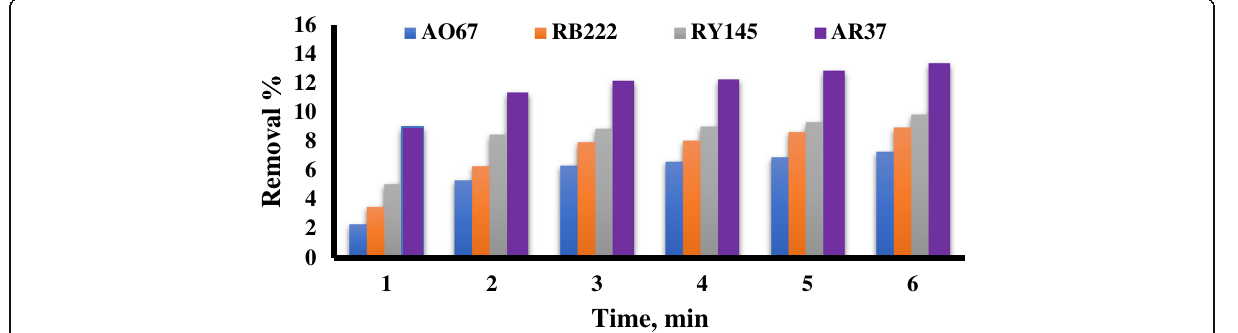
Fig. 21 Effect of contact time on adsorption capacity of RPSF to RB 222, RY 145, AO67, and AR37 at optimum